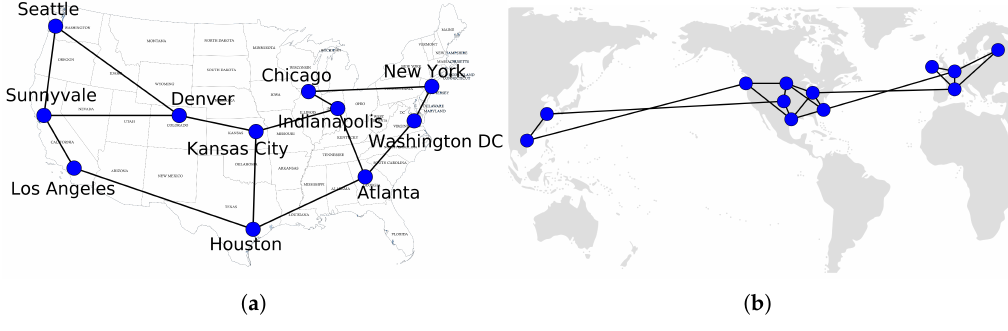
Figure 5. Topologies adopted in this work. ( a ) The representation of the Abilene topology. ( b ) The representation of a WAN Google topology.